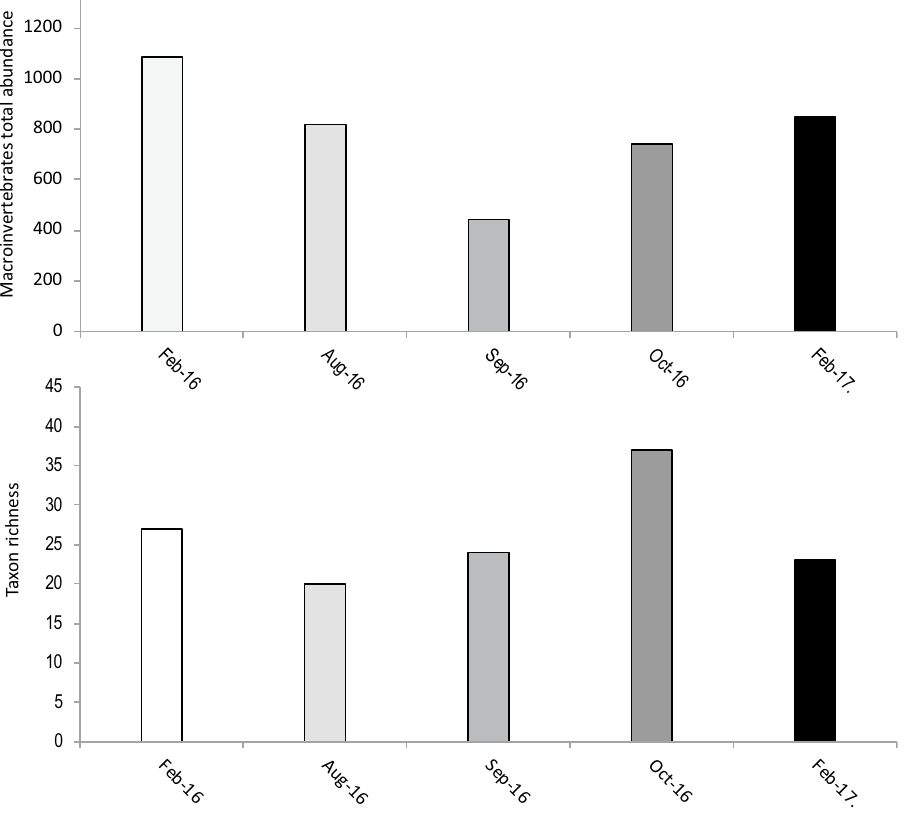
Figure 2. Seasons variation of macroinvertebrate total abundance and taxon richness in the upstream area adjacent to the studied site 1 of Valla